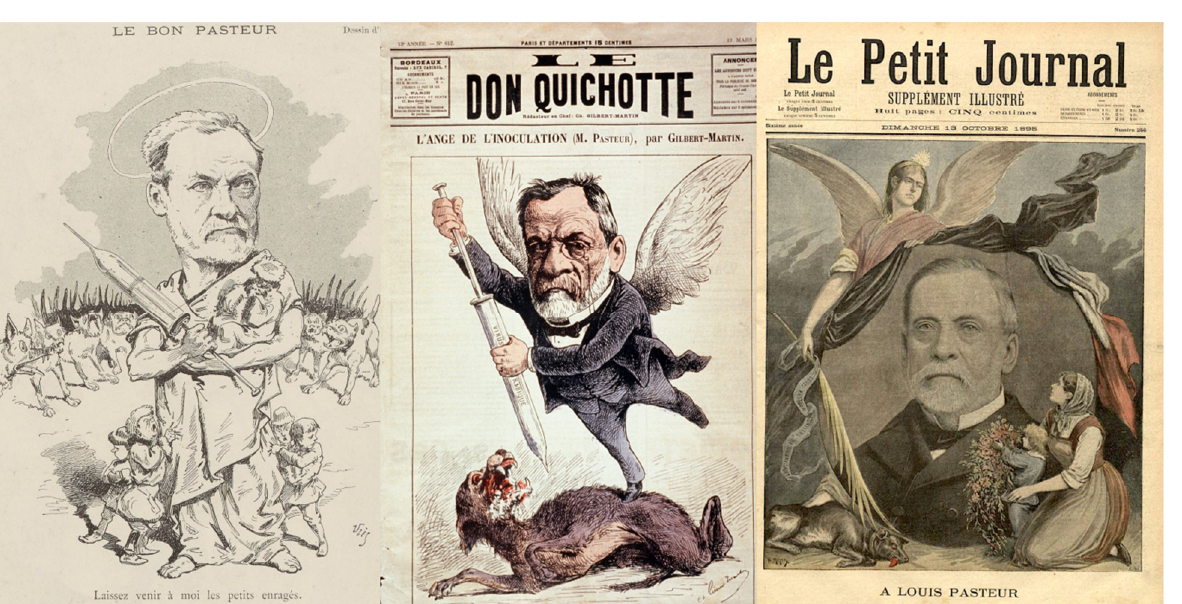
Figure 1. Left: Pasteur in the French Press seen as a lay saint ( Le Courrier Français , 4 April 1886); center: as an angel fighting rabies ( Le Don Quichotte , 13 March 1886); right: as a revered icon after his death ( Le Petit Journal , 13 October 1895). (© Institut Pasteur, Musée Pasteur).